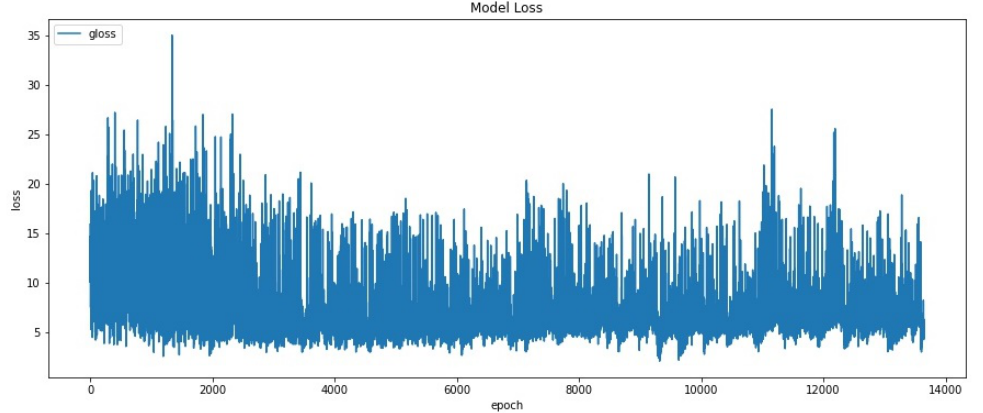
Figure 13. GAN Training Curve based on GAN